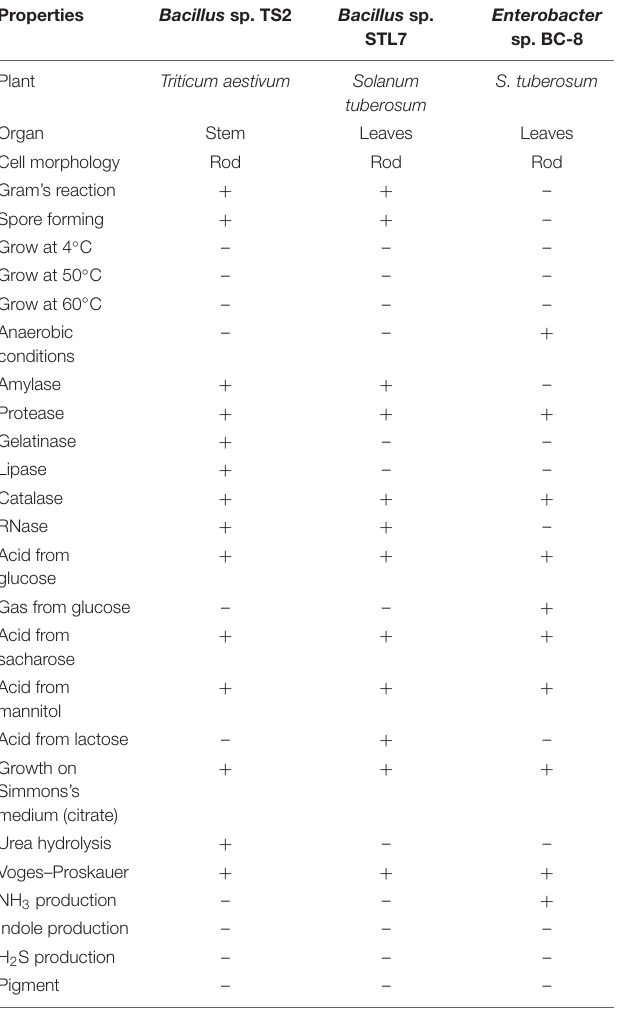
TABLE 1 | Biochemical and morphological characterization of bacterial isolates.